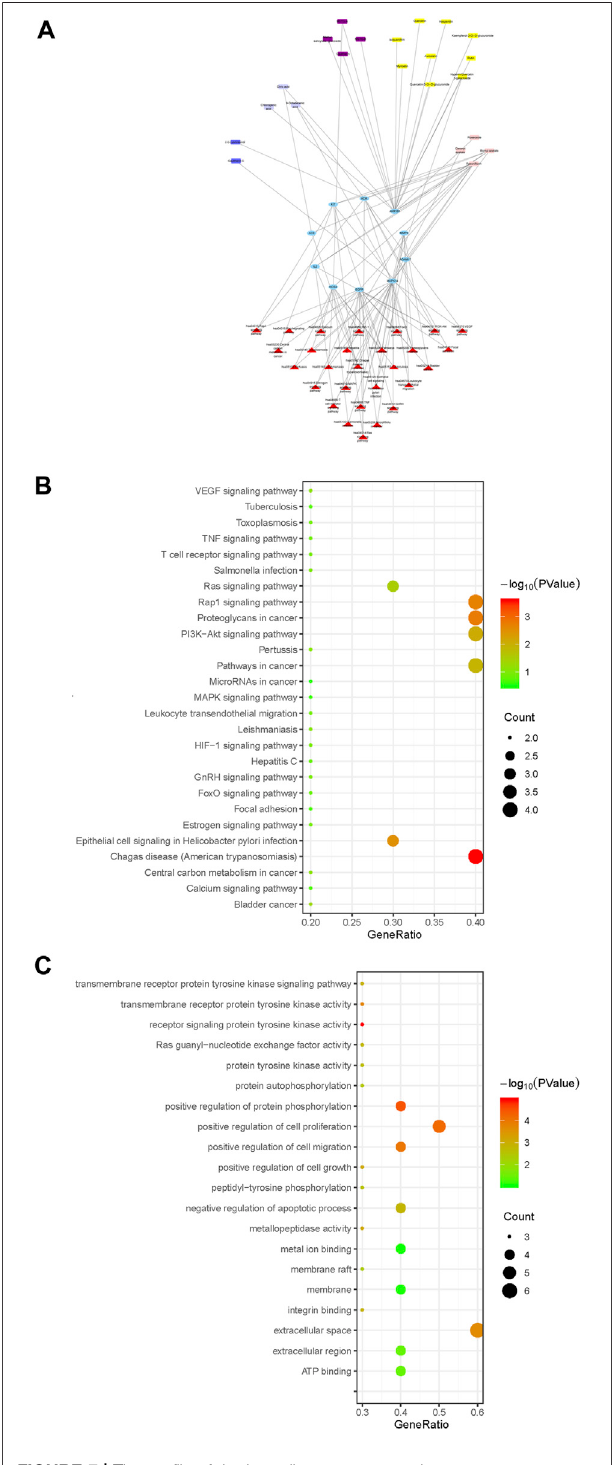
FIGURE 7 | other compounds). (B) KEGG pathway analyses of the ARF key target genes. The vertical and horizontal axes represent the pathway name and enrichment factors, respectively. The size of the dots demonstrates the FIGURE 7 | The pro fi le of the ingredients – targets – pathways amount of targets enriched. The color of the circular dots represents the relationships of ARF. (A) Components – core target – pathway network of ARF. p -value, and red to green indicate p -values from small to large. (C) GO Blue elliptical nodes represent the key target, red triangles represent analysisofARFkeytargetgenes.TheverticalaxisisthenameoftheGOitems, pathways, the other colors represent different types of components in and the horizontal axis the enrichment factor. The size of the points indicates ARF (yellow, purple, blue, lavender, and light pink rectangle, respectively, the number of the targets enriched. The color of the dot represents the represent fl avonoids, methyl salicylate glycosides, lignans, organic acids, and p -value, and red to green represent p -values from small to ( Continued )